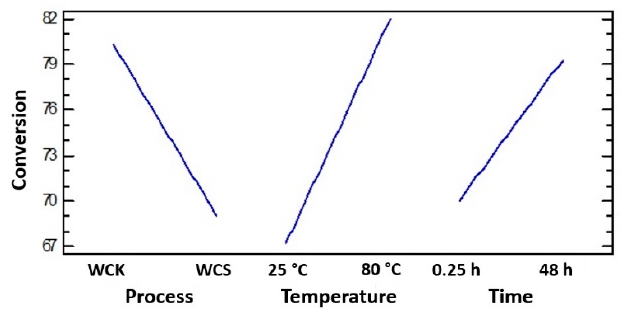
Figure 9. Main effect plot for conversion relative to the WCK and WCS processes.